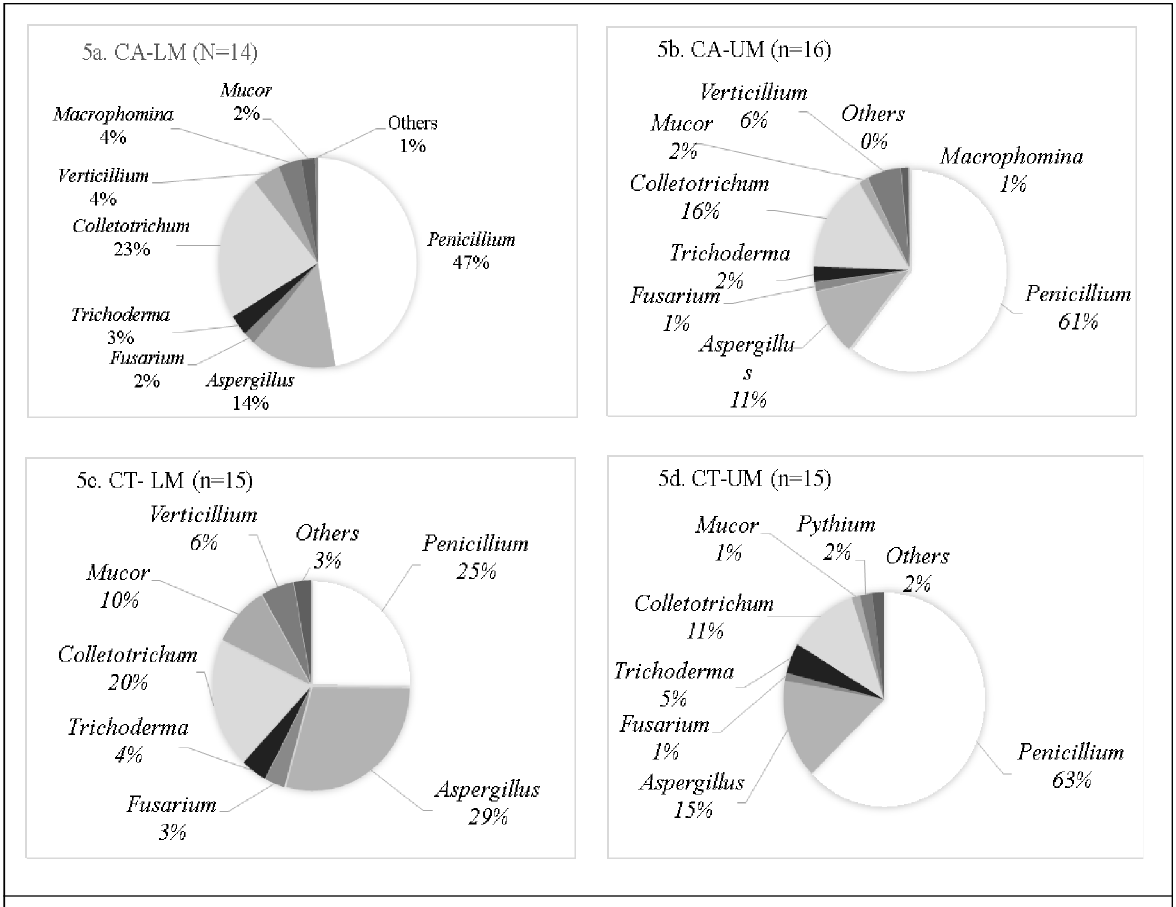
Figures 5a-5d: Effect of tillage method on soil fungal species relative composition Key: Others represent Pythium , Peronospora and Rhizopus for CA-LM 4 and CA- UM 3; Macrophomina , Pythium , Rhizopus and Peronospora for CT-LM 4; Verticillium, Marophomina, Rhizopus and Perenospora for CT-UM